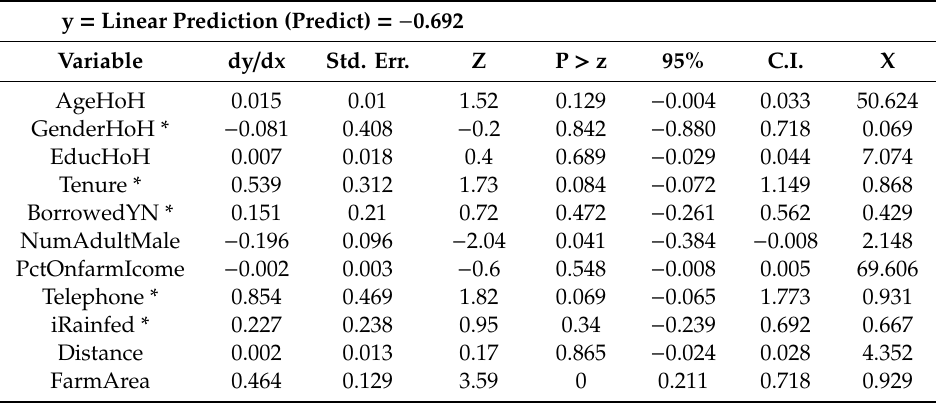
Table 6. Marginal e ff ect after multivariate probit analysis due to change in frequency of drought. y = Linear Prediction (Predict) = −